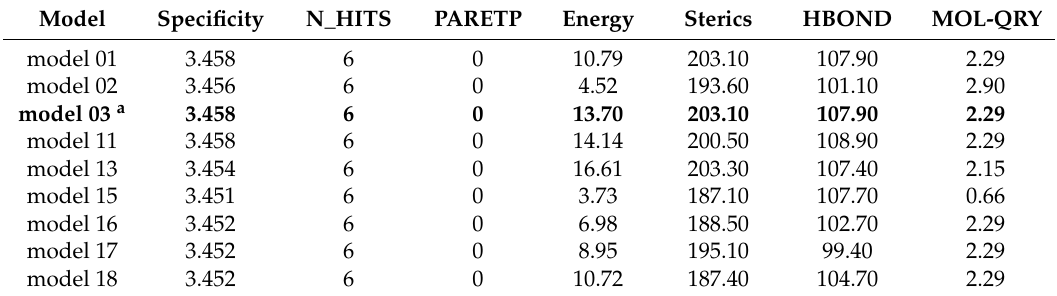
Table 1. The result of the pharmacophore models of orthosteric antagonist of mGluR